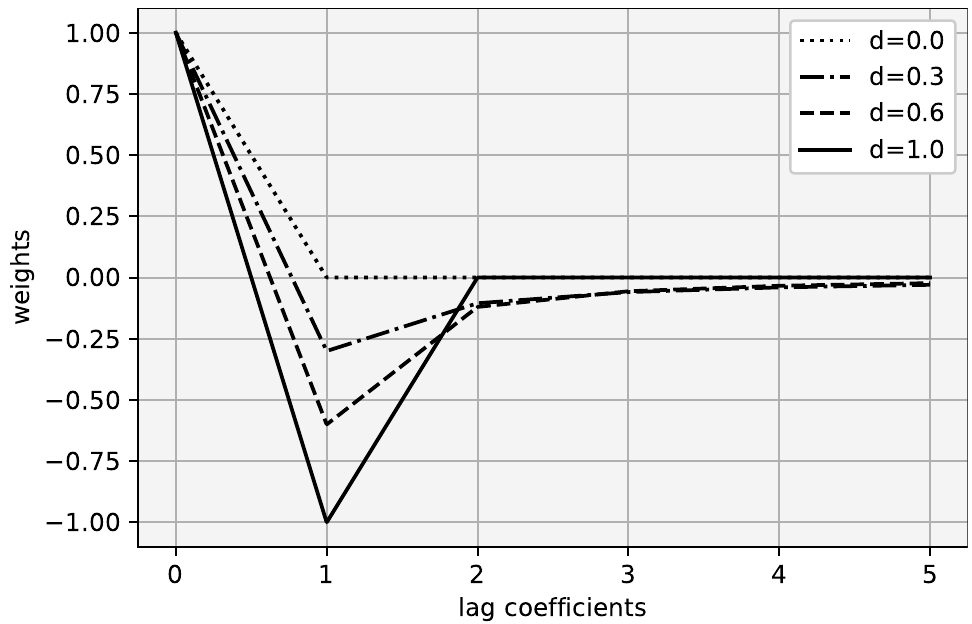
Figure 1. Weights distributed to different lag